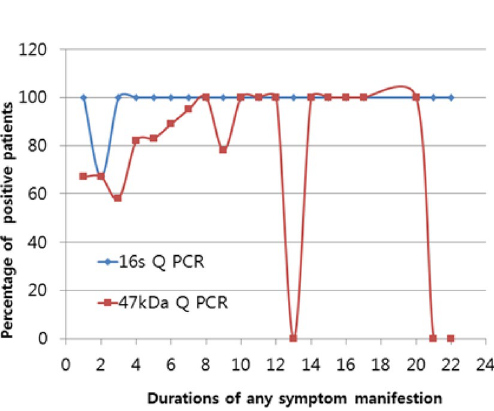
Figure 4. Positivity percentages of 47-kDa real-time PCR and 16s rRNA real-time PCR according to the durations of symptom